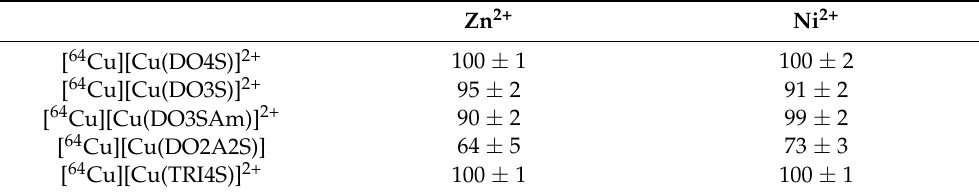
Figure 5. Relative abundance of the different [ 64 Cu]Cu 2+ complexes obtained with the sulfur-rich cyclen-based chelators in the challenge assays with DOTA (1:1 DOTA-to-chelator molar ratio) at ( A ) pH 4.5 and ( B ) pH 7 after 10 min reaction at RT. Table 1. Labelling efficiency (%) in the presence of a molar excess (2-fold with respect to the chelator) of competitive metal ions.